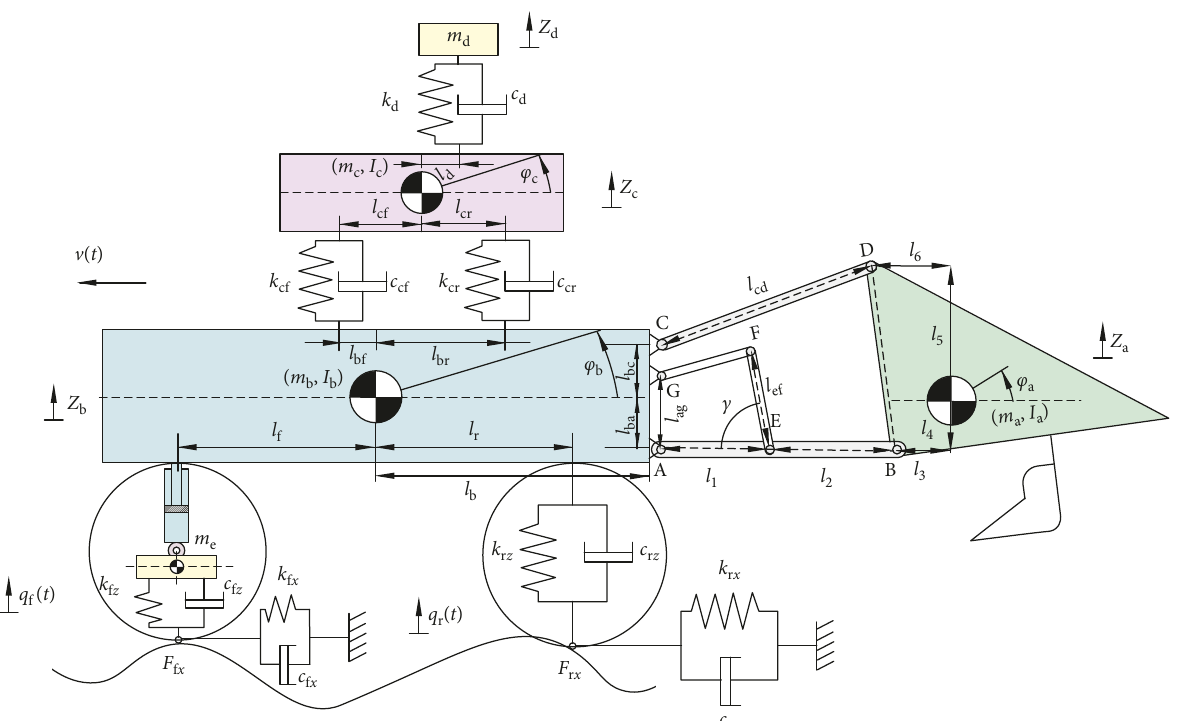
Figure 3: Dynamic model of the wheeled tractor system with the implement and front axle hydropneumatic suspension.